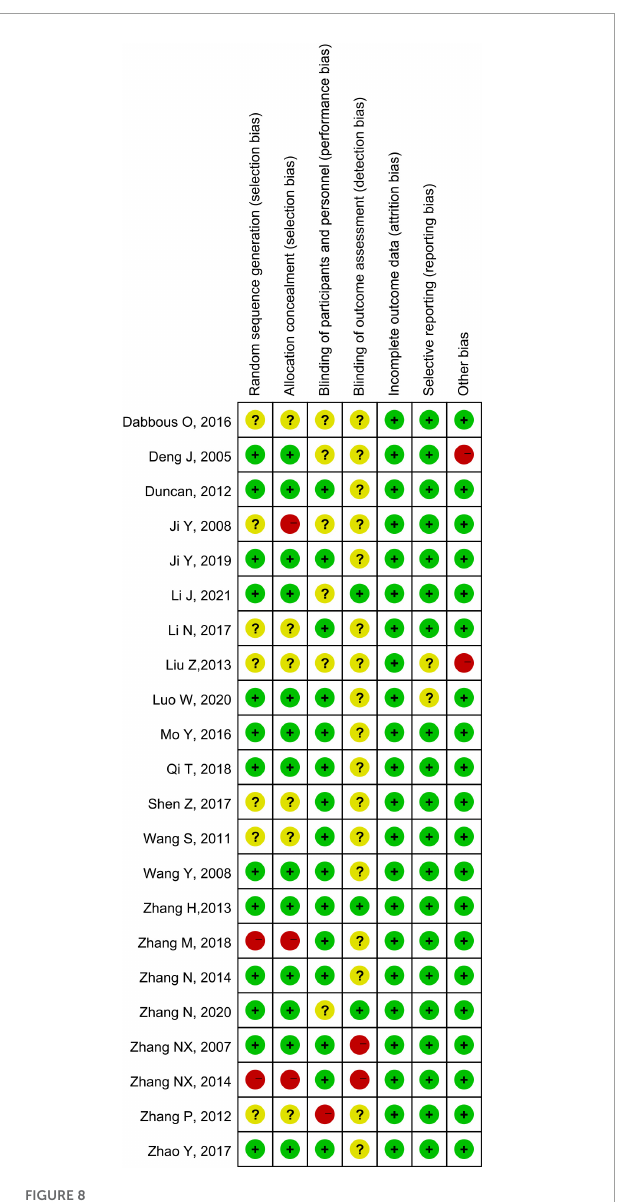
FIGURE8 The bias chart of the included studies assessed by the Cochrane risk of bias